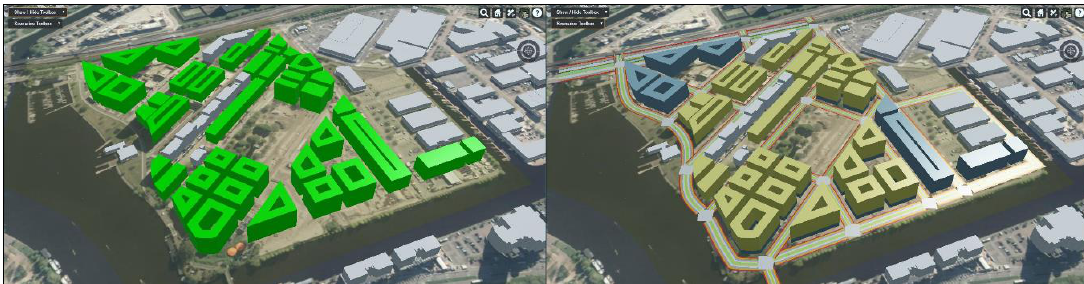
Figure 7. Example of two scenarios, identified as Scenario A and Scenario B, and generated in Rhinoceros/Grasshopper during the urban-design process. Scenario B is visualized in CesiumJS in Figures 8 and 9.